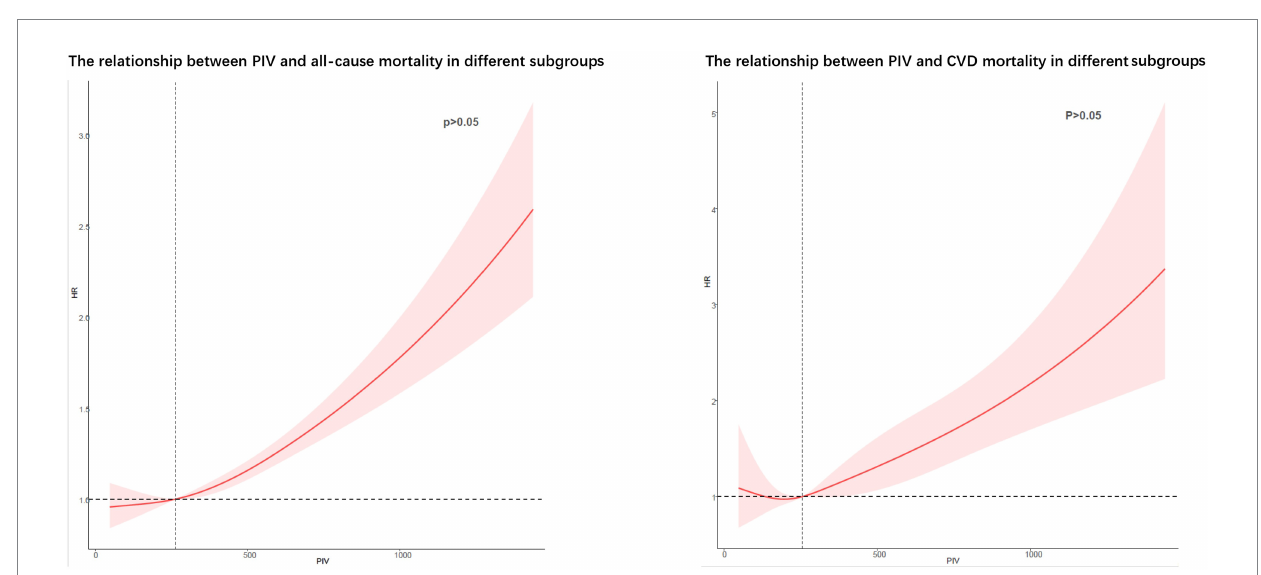
FIGURE 6 Potential non-linear relationships between PIV and all-cause and cardiovascular death